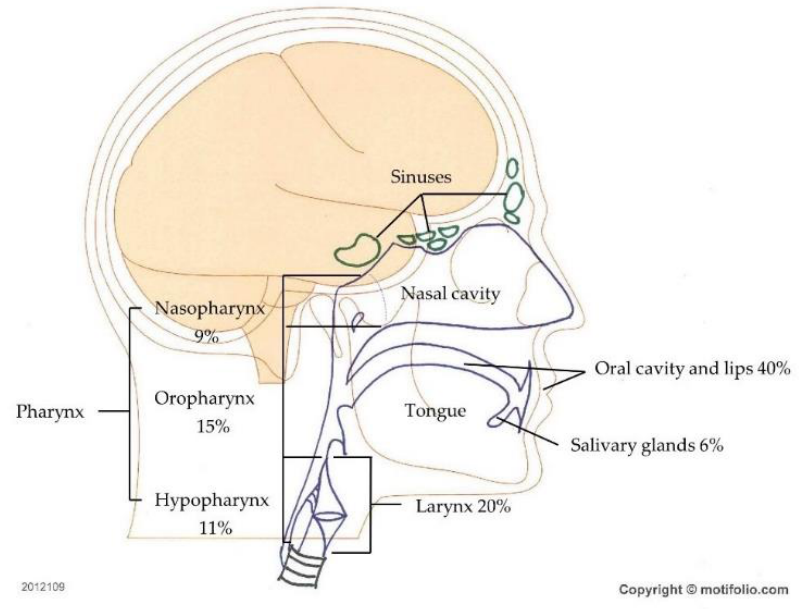
Figure 1. Head and neck cancer (HNC) types. Regions and frequencies where head and neck cancers are diagnosed are indicated.